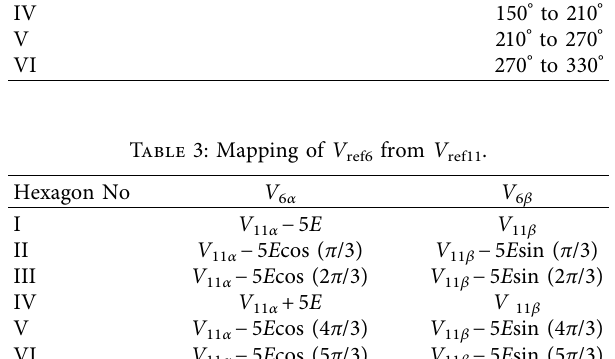
Figure 3: Disintegration of 6L SVD to lower-level hexagons.